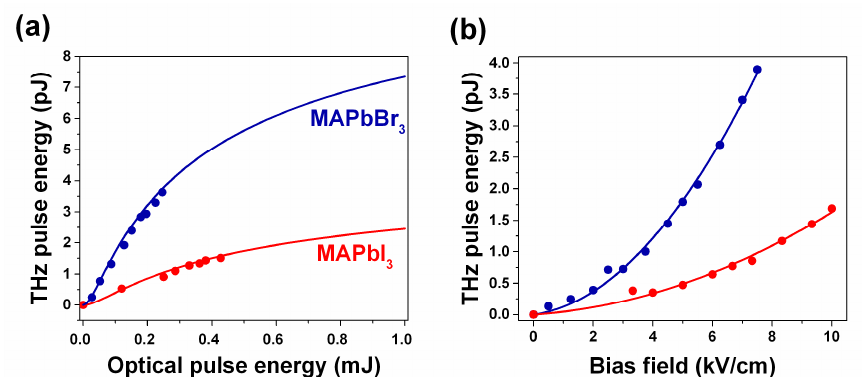
Figure 6. The terahertz pulse energy as a function of the optical excitation energy ( a ) and applied bias voltage ( b ) obtained from the HP-LAPCA optically excited above the bandgap (400 nm). The data obtained for HP-LAPCAs based on MAPbI 3 and MAPbBr 3 are shown with red and blue colors correspondingly.